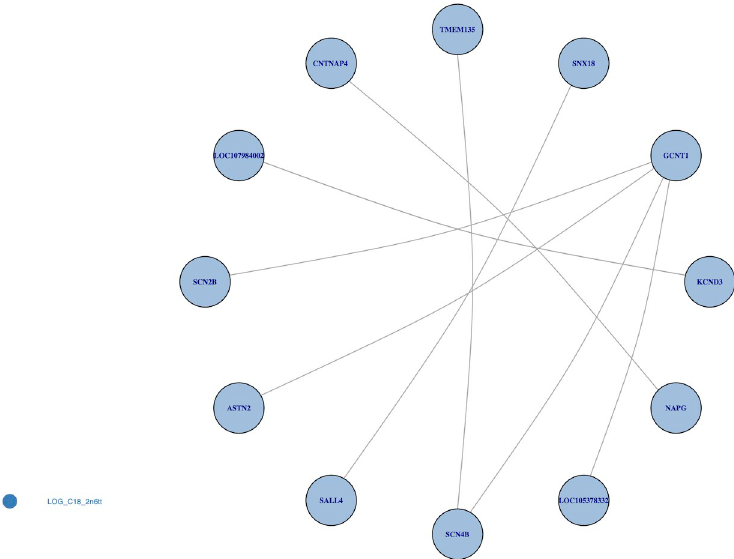
Fig 10. Mapping significant interactions at the gene level with Bonferroni adjusted p < 0.05. The Bonferroni significant interactions with gene annotations were selected. Only the omega-6 fatty acid (C18:2n6tt) had Bonferroni significant interactions that mapped to genes. Genes GCNT1 and SCN4B were involved in multiple interactions.